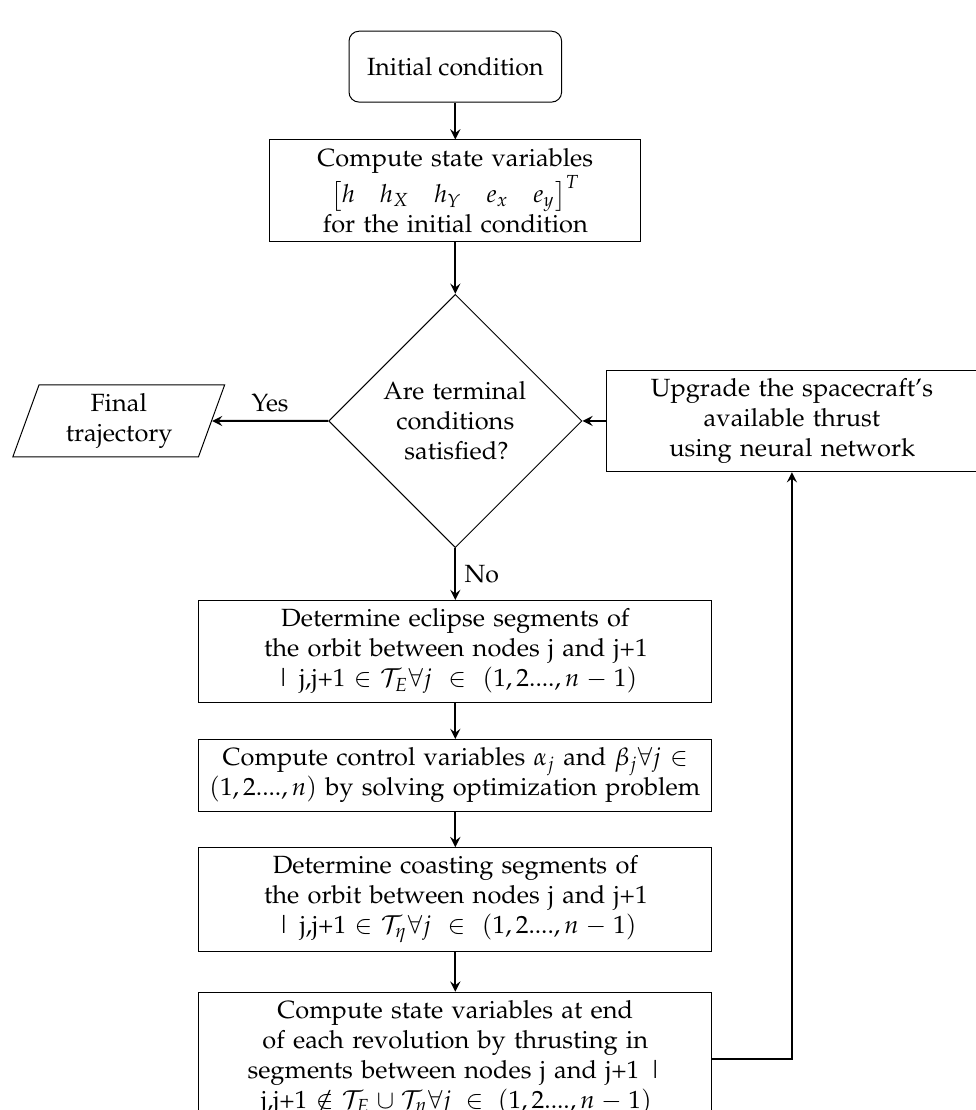
Figure 6. Algorithm flow